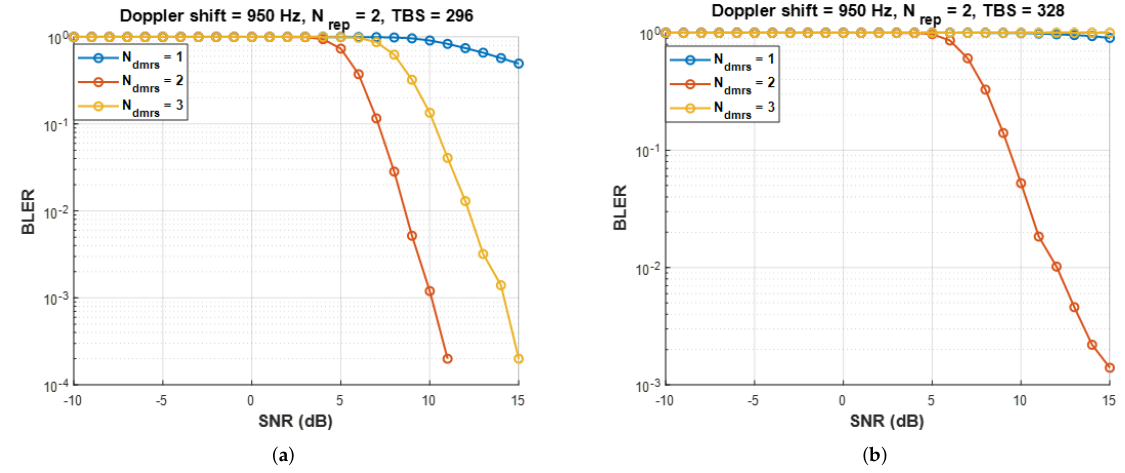
Figure 12. Uplink transmission BLER result according to TBS with various numbers of DMRS symbols. Doppler shift = 950 Hz, ( a ) TBS = 296 bit, ( b ) TBS = 328 bit.